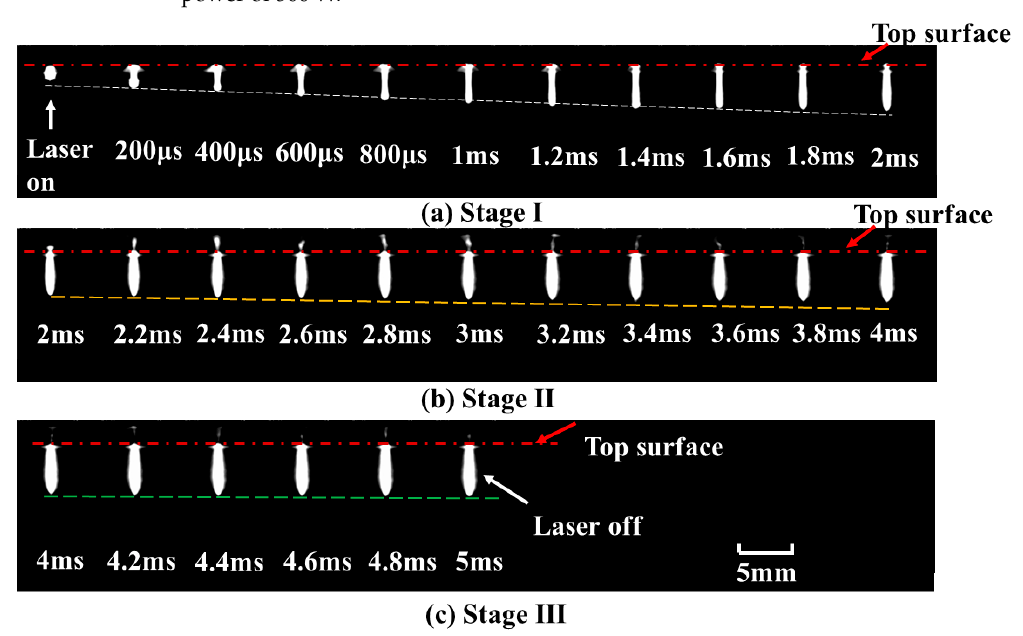
Figure 9. Three stages of keyhole evolution with a pulse width of 5 ms during single-pulse laser drilling at a peak power of 500 W. ( a ) stage I: 0–2 ms, ( b ) stage II: 2 ms–4 ms, ( c ) stage III: 4 ms–5 ms.